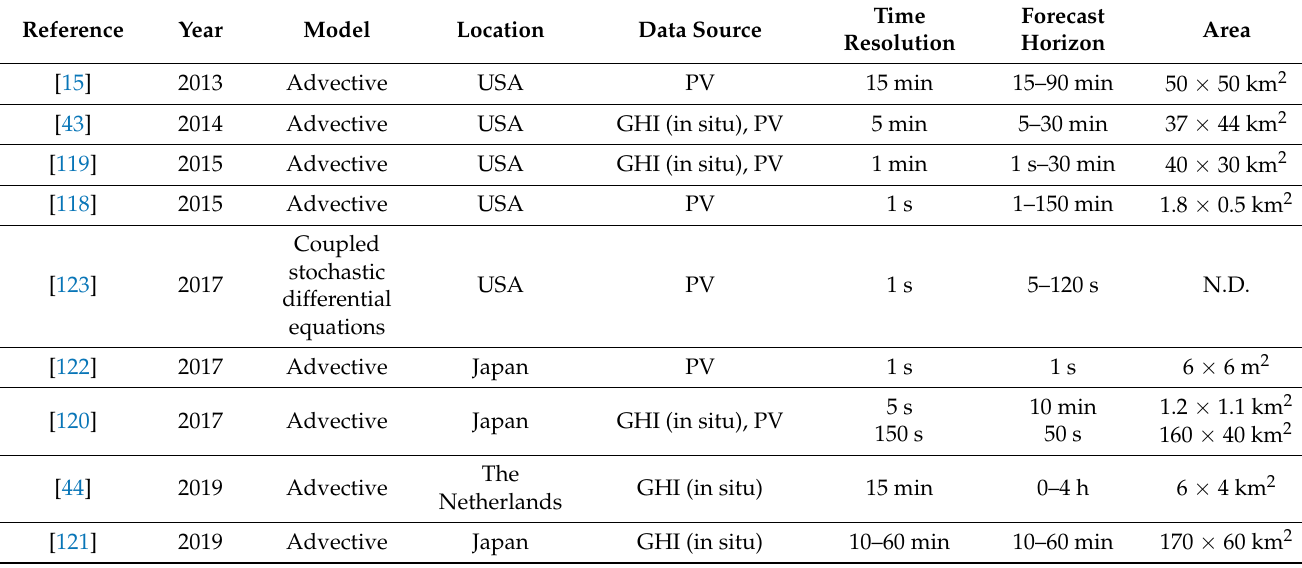
Table 5. Summary of available literature (2013–2019) for the application of physical methods regard- ing spatio-temporal solar forecasting